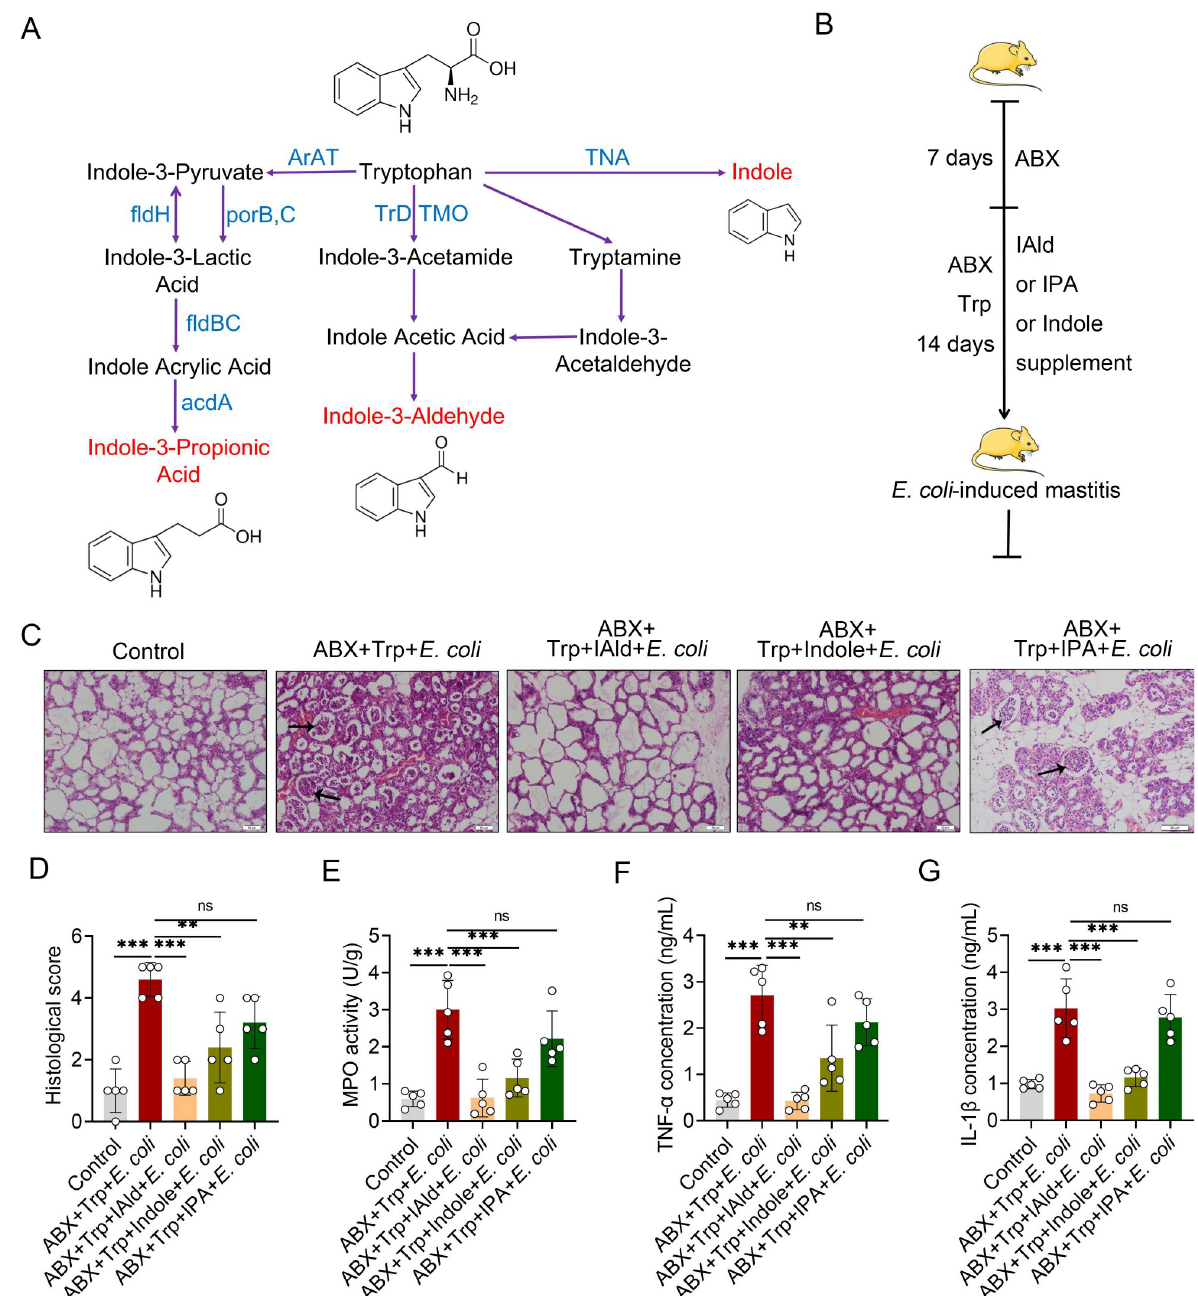
Fig 6. Tryptophan metabolized AhR ligands by intestinal microbiota ameliorate E . coli -induced mastitis in dysbiotic mice. (A) Tryptophan microbiota metabolism. ( B) Schematic representation of AhR ligands rescue. The mice were treated with ABX for a week for microbiota depletion, followed by IAld, indole or IPA supplementation for 2 weeks in the context of tryptophan (1%) and ABX treatment before mastitis induced by E . coli stimulation (10 7 CFU/50 μ L by intra-breast injection). ( C) Representative figures of H&E-stained mammary gland sections from tryptophan- derived AhR ligand supplemented mice. The black arrow indicates inflammatory cell infiltration (scale bar, 50 μ m). (D) The histological score based on H&E-staining sections (n = 5). ( E) The MPO activity from differently treated mice mammary glands (n = 5). Inflammatory cytokines TNF- α ( F ) and IL-1 β ( G ) from different groups (n = 5). The data are presented as the means ± SEM (D-G). ns, no significance, � p < 0.05, �� p < 0.05, and ��� p < 0.001 indicate statistical significance by one-way analysis of variance. IAld, indole-3-aldehyde; IPA, indole-3-propionic acid; acdA, acyl-CoA dehydrogenase; AraT, aromatic amino acid aminotransferase; fldBC, phenyllactate dehydratase; fldH, phenyllactate dehydrogenase; porB, C, pyruvate: ferredoxin oxidoreductase B and C; TMO, tryptophan 2-monooxygenase; TNA, tryptophanase; TrD: tryptophan decarboxylase.